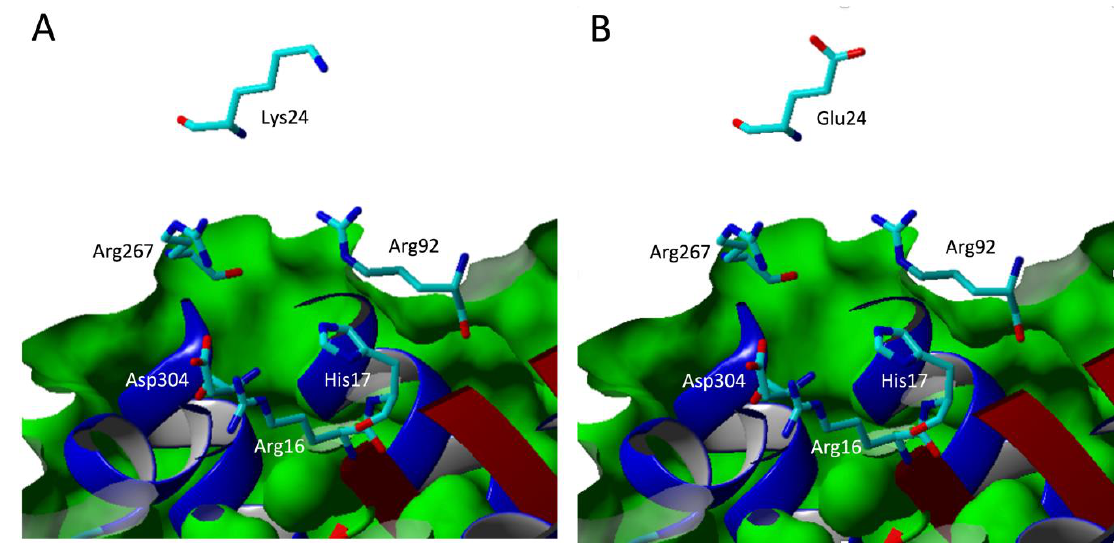
Figure 12. Mutation on phytase from Escherichia coli . ( A ): Location of residue K24 at surface of the pocket edge. ( B ): Substitution K24E. Part of the secondary structures was cut to reveal location of residues near the binding pocket using YASARA Structure software.